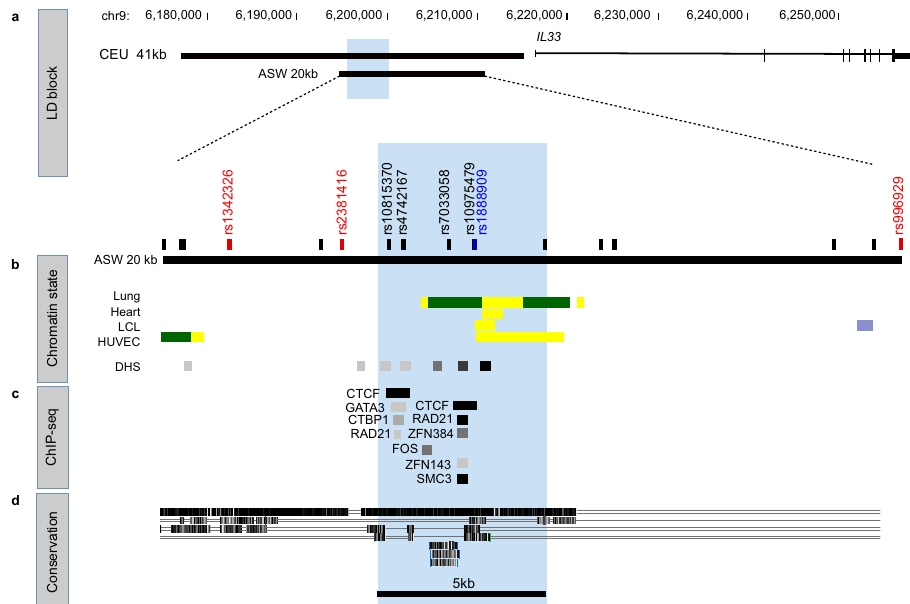
Fig. 1 Epigenetic characterization of the asthma-associated critical region in the IL33 locus. a Schematic organization of the IL33 gene and the asthma- associated region (black bars) of European ancestry (CEU 41 kb, chr9: 6,172,380 – 6,213,468; hg19) and African ancestry (ASW 20 kb, chr9: 6,188,124 – 6,209,099; hg19) positioned upstream of exon 1. b Position of the lead GWAS SNPs (in red) and additional SNPs in high LD ( r 2 ≥ 0.8) with the lead SNPs (in black) within the ASW 20 kb LD region. The lead SNP rs1888909 in African ancestry is shown in blue. Chromatin states from Roadmap Epigenomics Project showing regions with potential regulatory activity. Yellow: active enhancer; green: transcribed sequence; blue: heterochromatin. DNase hypersensitive (DHS) sites indicating open chromatin regions are shown. Tissues (from the top): E096 Lung primary HMM; E095 Left ventricle primary HMM; E116 GM128781 Lymphoblastoid cell primary HMM; E122 HUVEC Umbilical Vein Endothelial Primary Cells Primary HMM. c ChIP-seq data from ENCODE-3 cell lines (338 factors; 130 cell types) showing co-binding of CTCF, RAD2, ZFNs, and SMC-3 at the 5 kb interval (blue shaded region; chr9: 6,194,500 – 6,199,500; hg19). d UCSC Multispecies conservation showing that the 5 kb region is not conserved across species. Organism (from the top): rhesus; mouse; dog; elephant. A single line means no bases in the alignment, and double lines indicate one or more unaligned